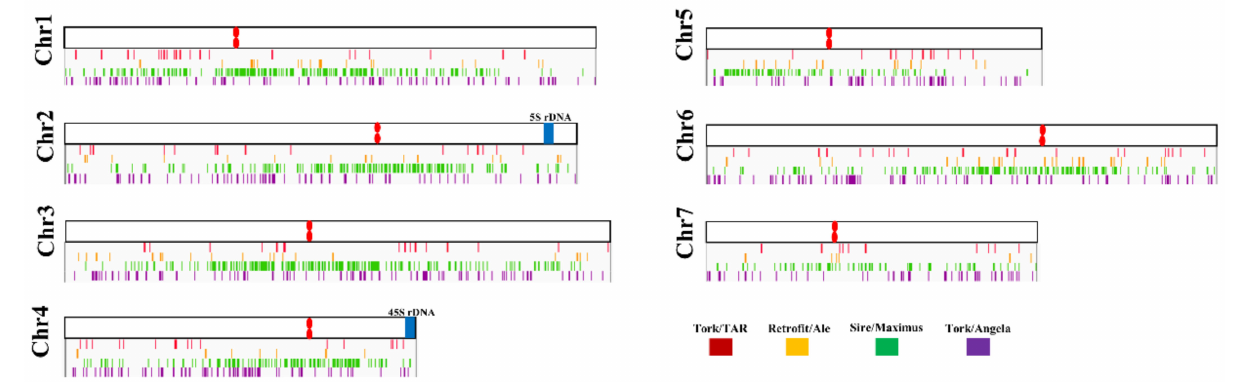
Figure 5. Genome distribution of RTs, 35S rDNA, and 5S rDNA in P. glaucum . The sequences of PpTy- copia -21 (Tork/TAR), PpTy- copia -46 (Retrofit/Ale), PpTy- copia -69 (Sire/Maximus), and PpTy- copia -87 (Tork/Angela) were used for alignment with P. glaucum genome.